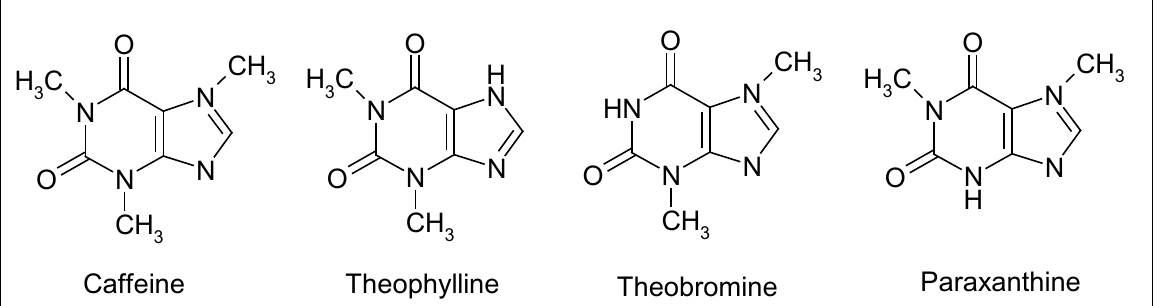
Figure 14. Caffeine and structurally related methylxanthines found primarily in tea (theophylline) and chocolate (theobromine); paraxanthine is the main hepatic metabolite of caffeine after coffee